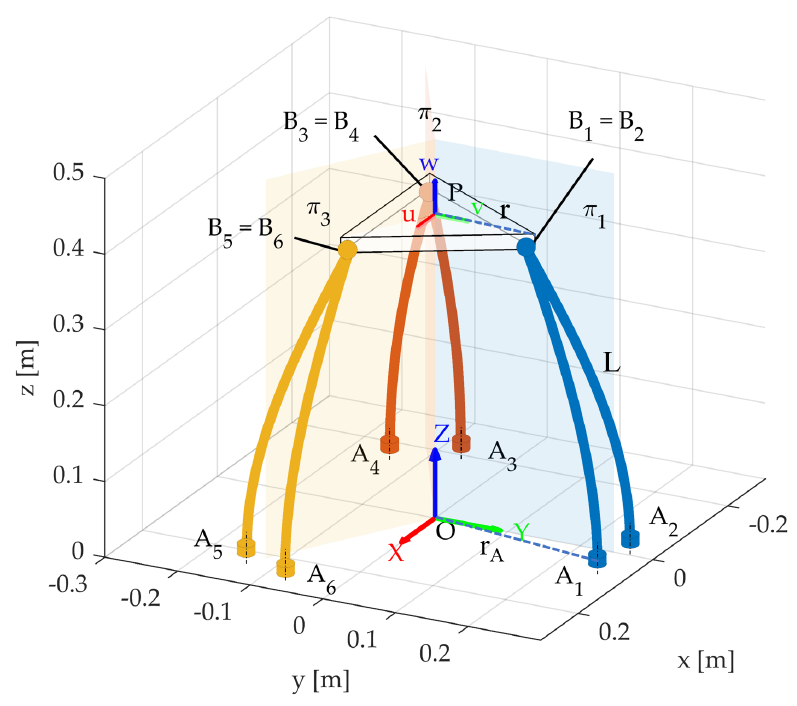
Figure 3. Flexible tripod: 3 PFS